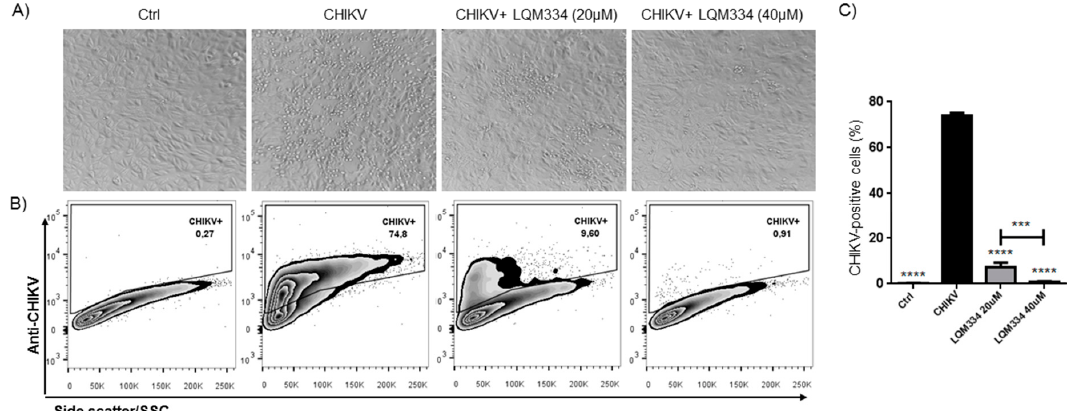
Figure 8. LQM334 inhibited the Chikungunya virus infection in vitro. In ( A ), Representative micrographs showing the cytopathogenic effect induced by the virus such as cell refringence changes and cell aggregates (200x magnification); In ( B ), Representative flow cytometry dot-plots of Vero E6 cells infected (CHIKV) or uninfected (Control) with CHIKV. The cells were treated with LQM334 at 20 and 40 µM, respectively. The percentages of CHIKV-positive cells are shown; In ( C ), The expressed values are results from mean ± SD of triplicates. *** p ≤ 0.001; **** p ≤ 0.0001 versus untreated infected cells (CHIKV). CHIKV = CHIKV-infected untreated cells. Control/ctrl = uninfected cellular control.